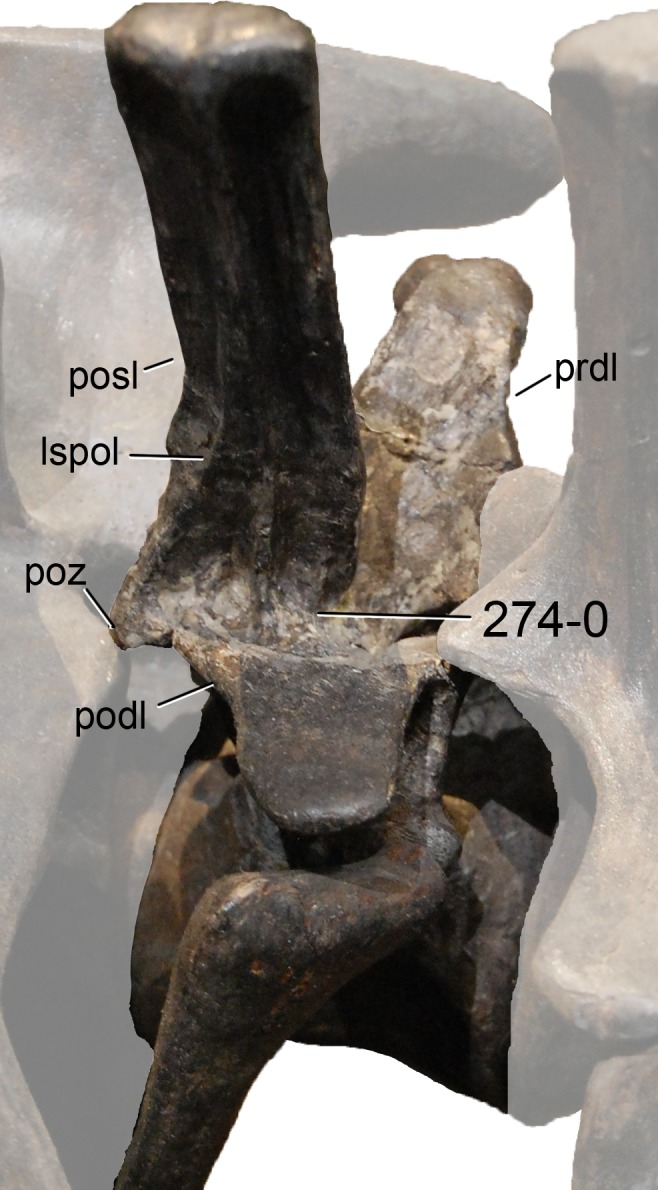
Posterior dorsal vertebra of “Elosaurus” parvus CM 566 in lateral anterodorsal view.Note the greatly reduced spinoprezygapophyseal lamina, which does not reach the prezygapophysis (C274-0). Only the base of the neural arch is preserved (see Peterson & Gilmore, 1902). Abb.: lspol, lateral spinopostzygapophyseal lamina; podl, postzygodiapophyseal lamina; posl, postspinal lamina; poz, postzygapophysis; prdl, prezygodiapophyseal lamina.